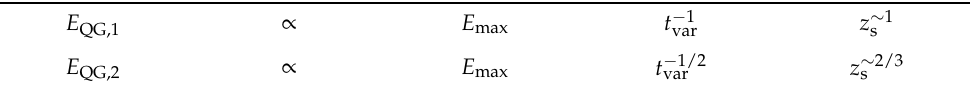
Table 1. Dependence of E QG, n on the characteristics of the source and the sample. E max is the highest photon energy in the sample, t var is the shortest variability timescale in the light curve, and z s is the redshift of the source. E QG,1 ∝ E max t − 1